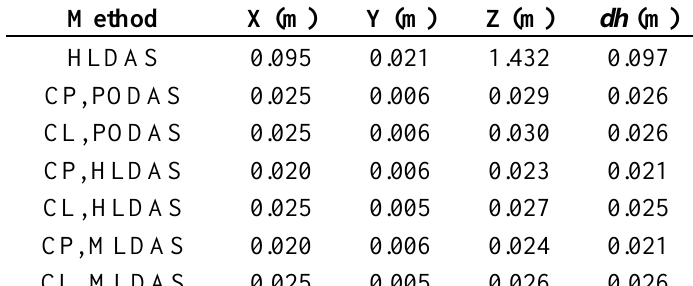
Table 2. Checkpoint RMSEs for Site 1.